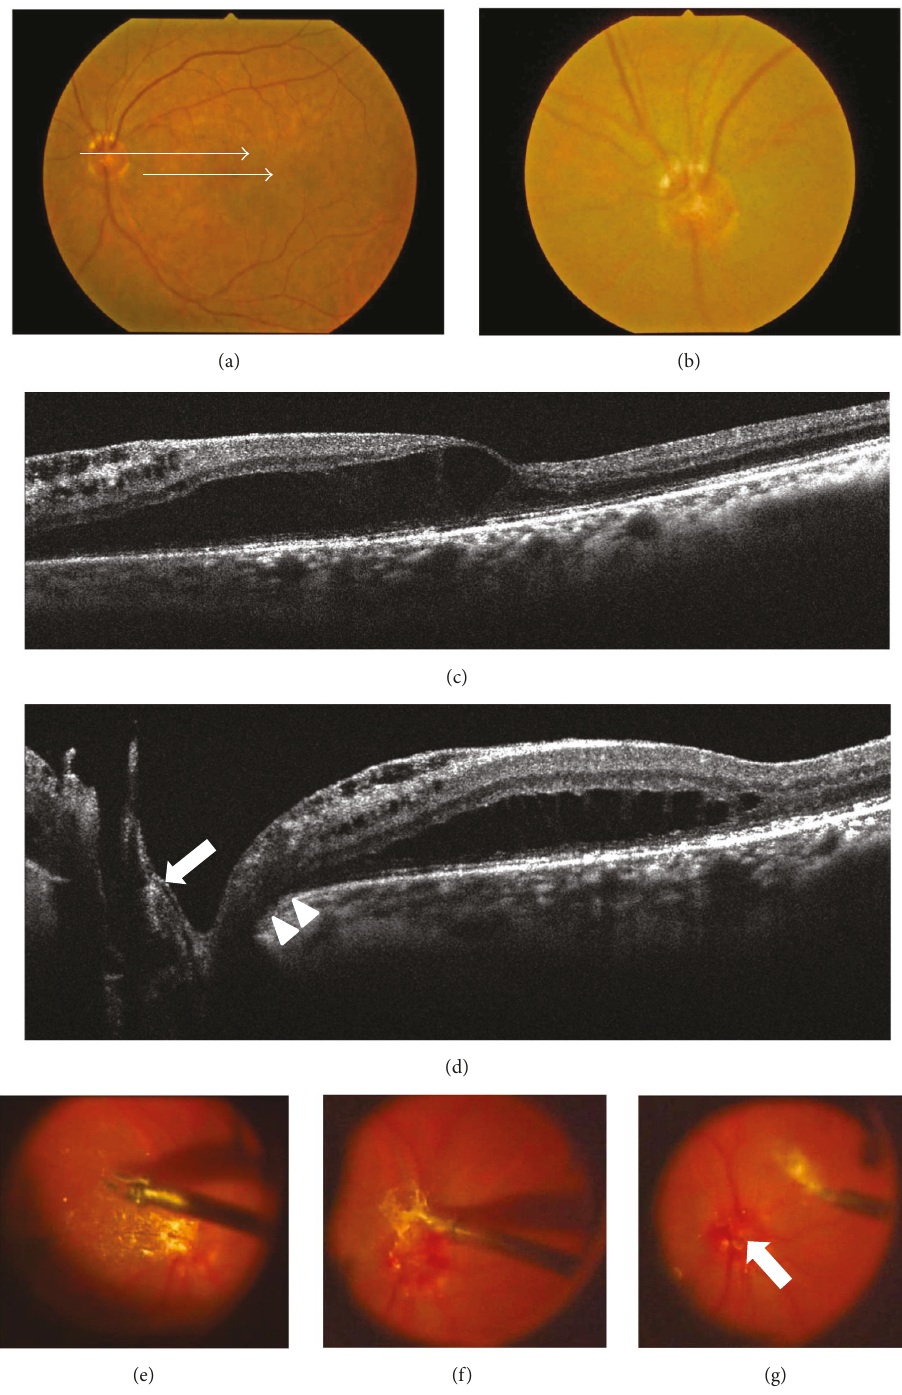
Figure 3: Photographs of the left eye in a 70-year-old patient with maculopathy in whom an optic disc coloboma became clear after surgery with epipapillary membrane removal (case 4). (a, b) Fundus photographs before surgery showing macular elevation (a) and a shallow cavitation in the center of the optic disc (b). Upper and lower arrows indicate the spectral domain optical coherence tomography (SD- OCT) scan in Figures 3(c) and 3(d), respectively (a). (c, d) SD-OCT images before surgery showing retinal schisis extending from the optic disc to the macula (c), with membrane tissue but with no obvious pit-like deep cavitation on the disc (d, arrow), and a shallow tunnel-like hypore fl ective lesion directly connecting the retinal schisis to the disc (d, arrowheads). (e – g) Findings during pars plana vitrectomy. Internal limiting membrane (ILM) at the area from the macula to the surrounding of the disc was peeled (e). ILM connected the membrane tissue on the optic disc (f). When the epipapillary membrane tissue was removed, a pit-like concavity, which was hidden behind the tissue, appeared (g,